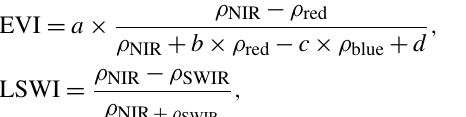
Figure 2. Flow chart of the method (adapted from Sakamoto et al., 2007) used to classify each pixel of the multispectral images ac- quired over the Mackenzie Delta in four categories (non-flooded, mixed, flooded and permanent water bodies) for each year from 2000 to 2015 using MODIS 8-day composite data from the day of the year (DOY) 169 to